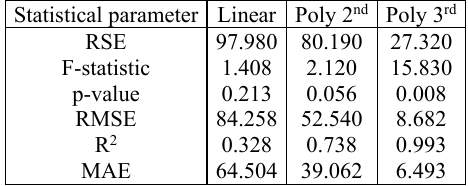
Table 3. Statistical parameters for accuracy assessment of three multiple regression analysis